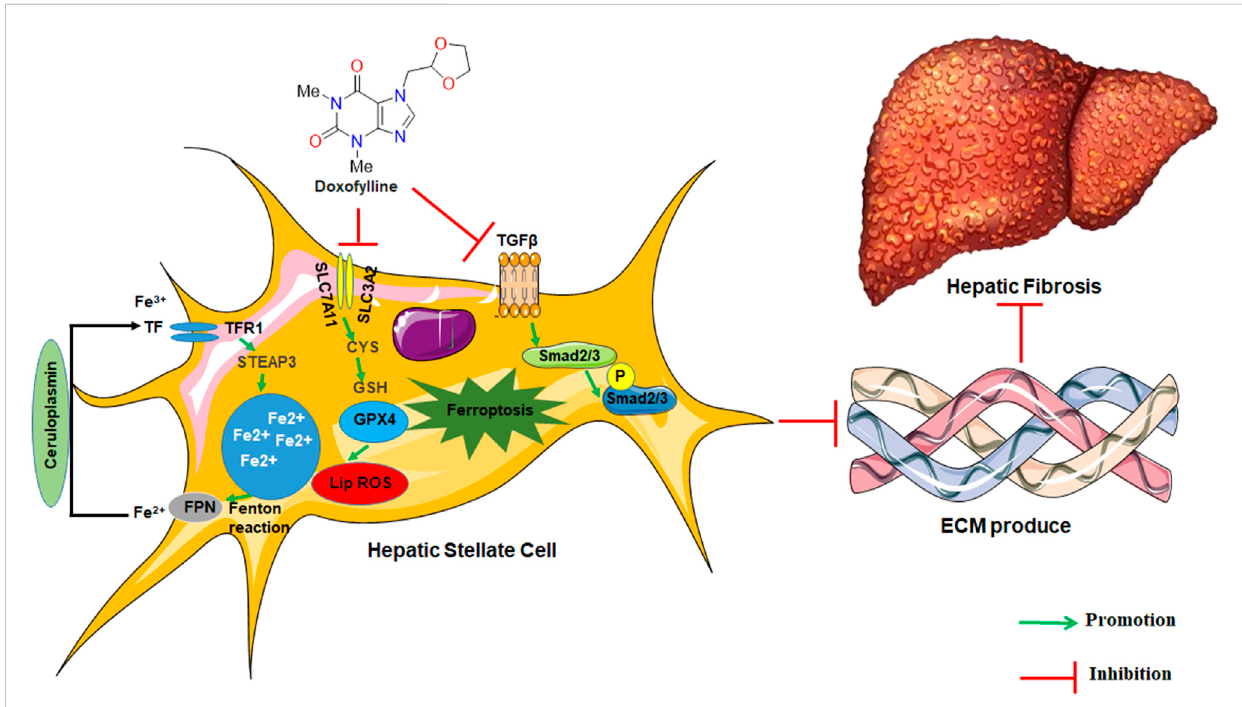
The graphic illustration of the mechanism of doxofylline protecting against liver fi